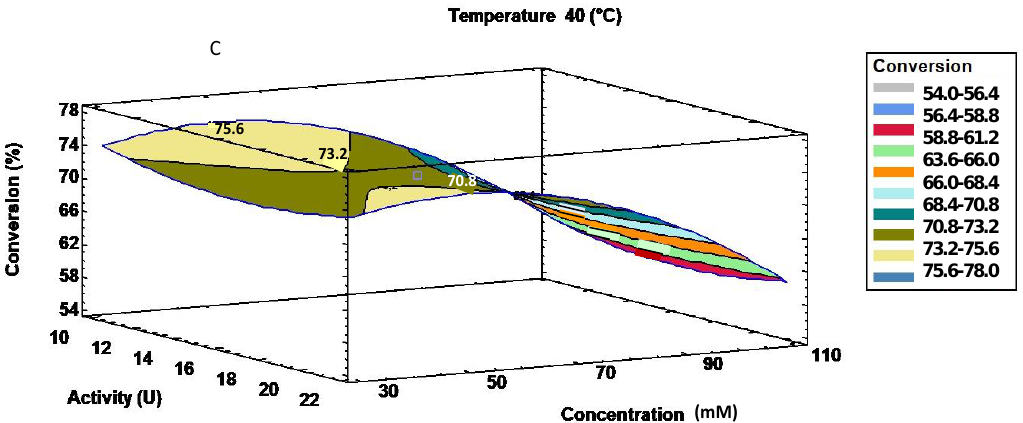
Figure 3. Effects of the variables studied on the conversion of HMF esterification with lauric acid (1000 mM) using Novozym 435 ® as biocatalyst. ( A ) Response surface for concentration of HMF, ( B ) response surface for the activity of biocatalyst, and ( C ) response surface for temperature.